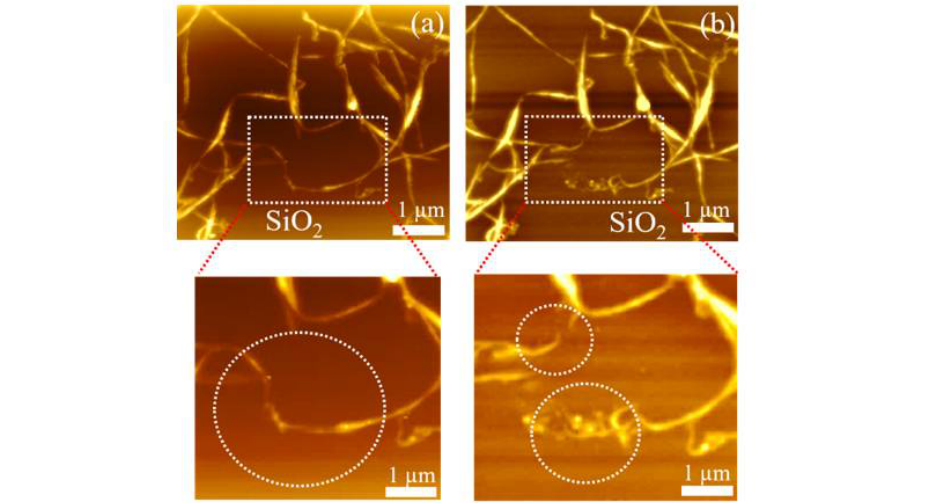
Figure 4. AFM images of a CNT-network deposited on a thermally-grown SiO 2 surface from NMP solution before ( a ) and after ( b ) AFM manipulation (performed only in the area indicated by the dotted box). Zoom-in images are shown below for clarity, illustrating two different effects in the encircled area: distortion (interruption) of a CNT-bundle (lower area encircled in ( b )) and shift of two branches of the CNT-network (upper area encircled in ( b )).